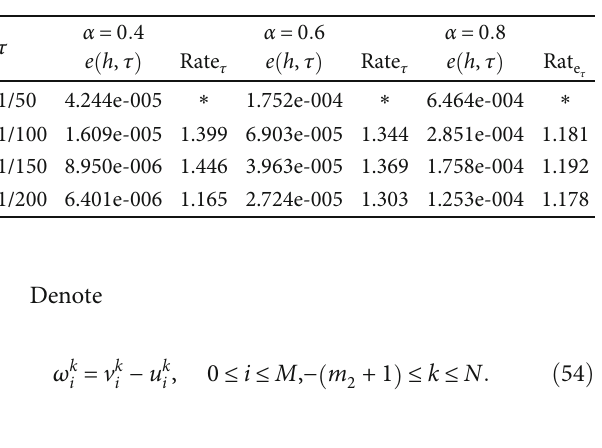
Table 2: Simulation results of Example 10, where τ = 1/2000 and α = 0 : 4,0 : 6,0 : 8 .